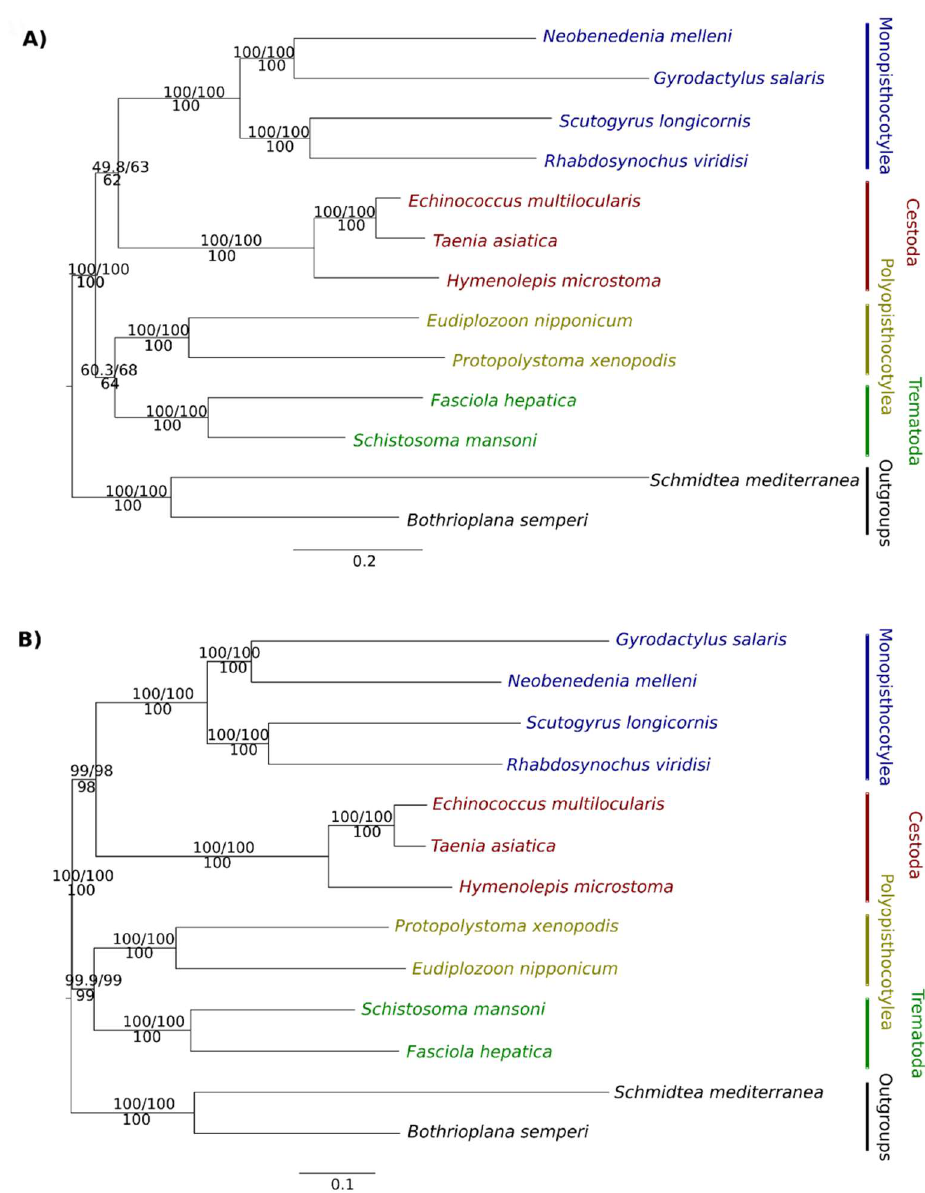
Figure 1. Phylogenetic trees of 13 platyhelminth species, based on ( A ) single-copy BUSCO OGPs and ( B ) simply OMA OGPs. Values above represent SH-aLRT support (%)/ultrafast bootstrap support (%) and below represent Maximum Likelihood rapid bootstrap support. The free-living platyhelminths Bothrioplana semperi , belonging to the order Bothrioplanida, and Schmidtea mediterranea , belonging to the order Tricladida, were used as outgroups.